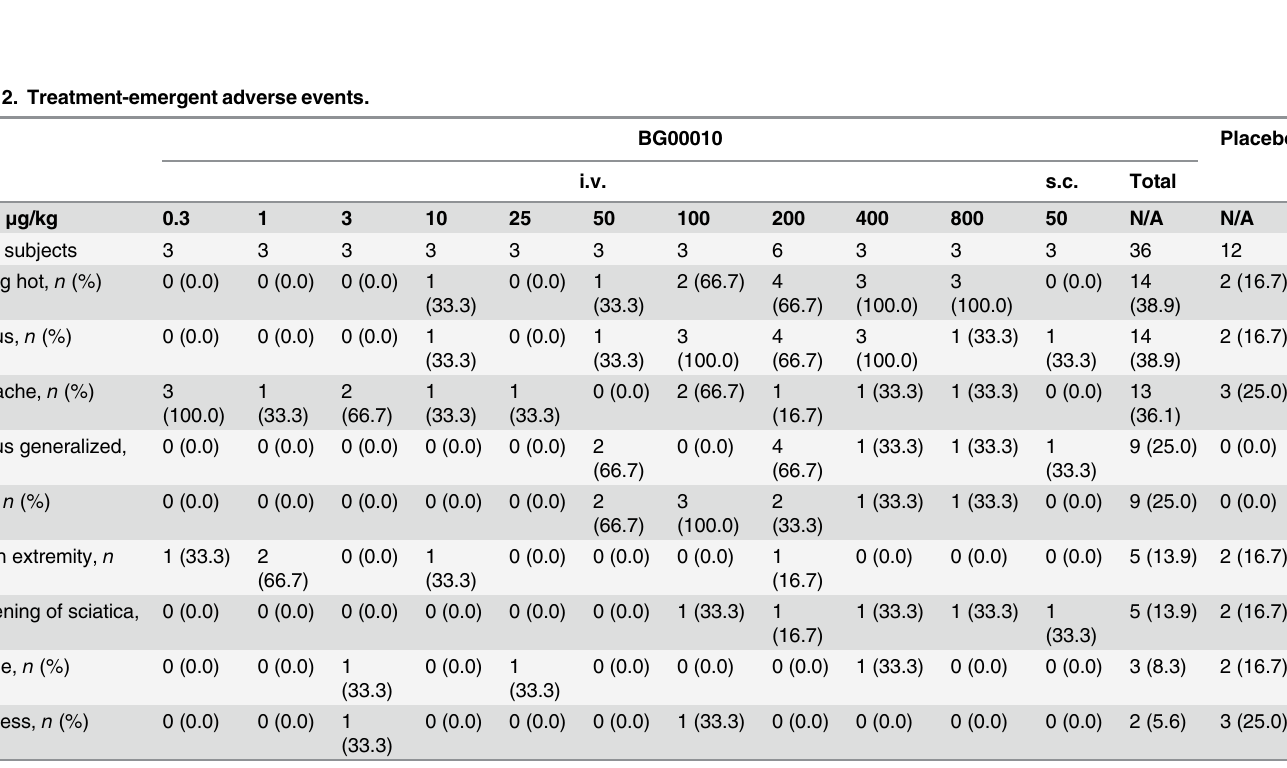
Table 2. Treatment-emergent adverse